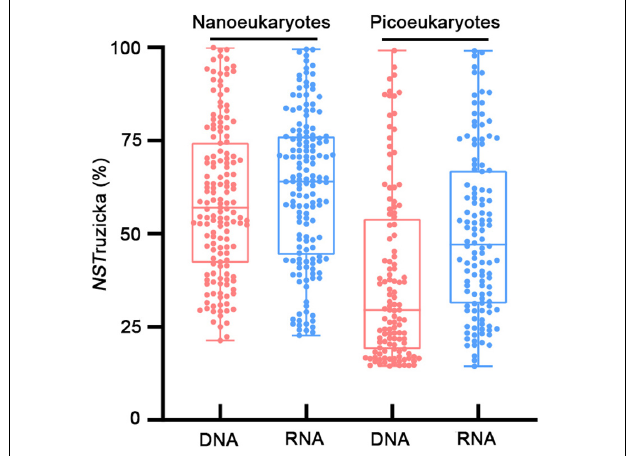
FIGURE 6 | Normalized stochasticity test values for the Ruzicka index (NST ruzicka